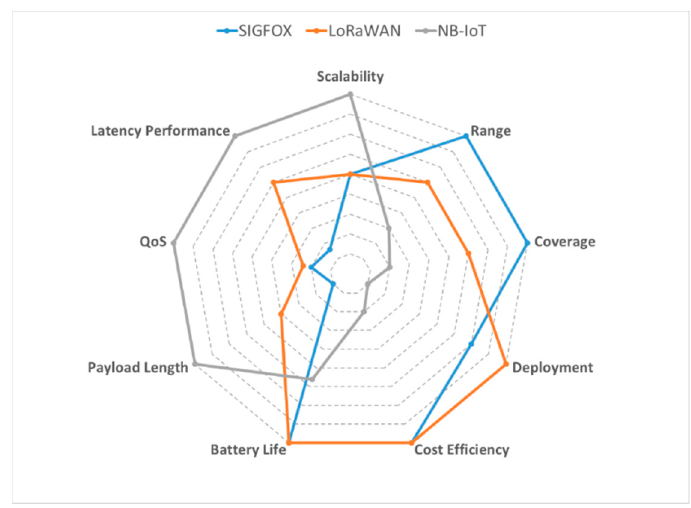
Figure 4. Qualitative comparison between SIGFOX, LORAWAN and NBIoT (Source: Own elaboration).